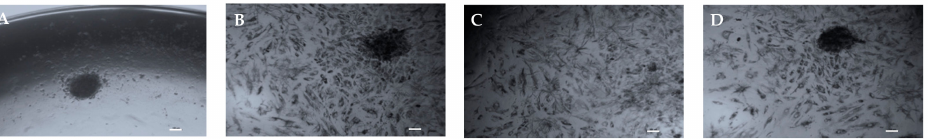
Figure 5. Microphotographs of spheroids stimulated with ( A ) vehicle, ( B ) Polynucleotides, ( C ) Polynucleotides and Hyaluronic acid, ( D ) Hyaluronic acid, after re-plating into regular cul- ture plates and cultured for 15 days. Spheroids that had been previously cultured in PN + HA dissolved completely after replating and their cells colonized the new plate. Spheroids previously cultured under different conditions were mostly retained, although some of their cells did spread out and grew on the new plates. Magnification 4 × . Bar = 50 µ